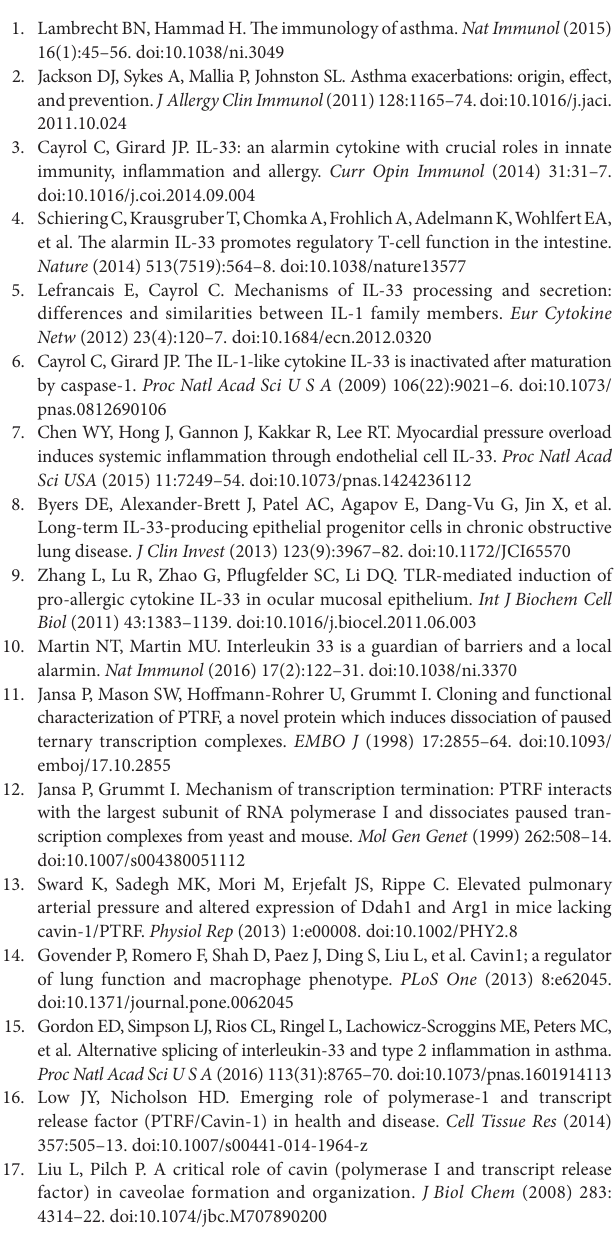
were immunoprecipitated with anti-HA or anti-Flag antibody followed by SDS-PAGE and blotted with indicated antibodies. FigUre s2 | Partial loss of polymerase I and transcript release factor (PTRF) does not affect airway inflammation during sensitization phase. Mice were intraperitoneally injected with phosphate-buffered saline or ovalbumin on days 0, 7, and 14 and then sacrificed on day 15. (a) Representative images of hematoxylin and eosin staining of lung tissue (upper panel), and periodic acid-schiff stain (lower panel). (B) Percentages of IL-4 + , IL-5 + , IL-13 + CD4 + T cells from lung, spleen, and peripheral lymph nodes of WT and PTRF + / − littermates. (c) IL-4, IL-5, and IL-13 levels in culture supernatant of lymphocytes from lung, spleen, and peripheral lymph nodes of WT and PTRF + / − littermates. Results are pooled data from four independent experiments (mean ± SEM of n = 4 mice in each group). FigUre s3 | Protein level of polymerase I and transcript release factor in